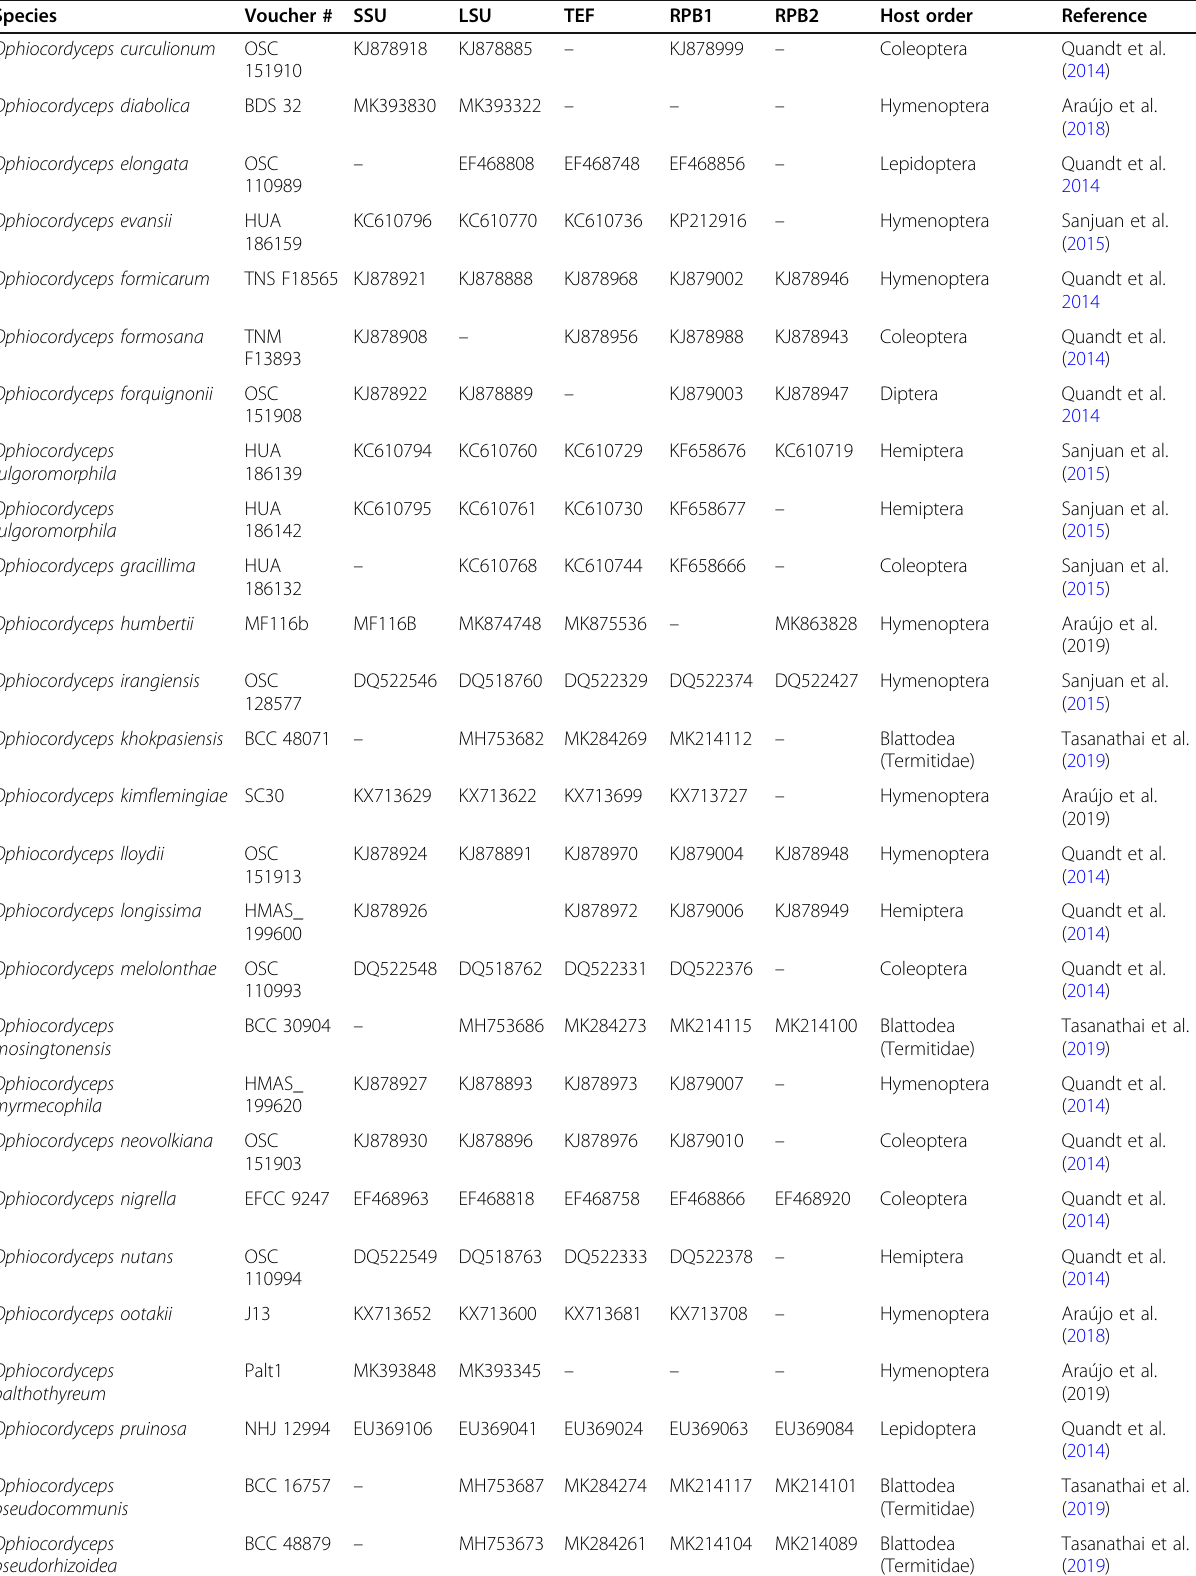
Table 3 Genbank accession number, host association and reference for all Ophiocordyceps species used in this study (Continued)